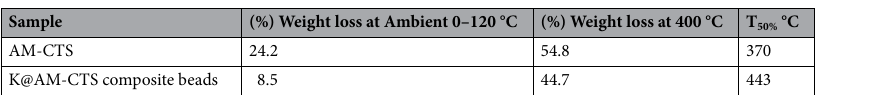
Table 1. TGA data of AM-CTS and K@AM-CTS composite beads.